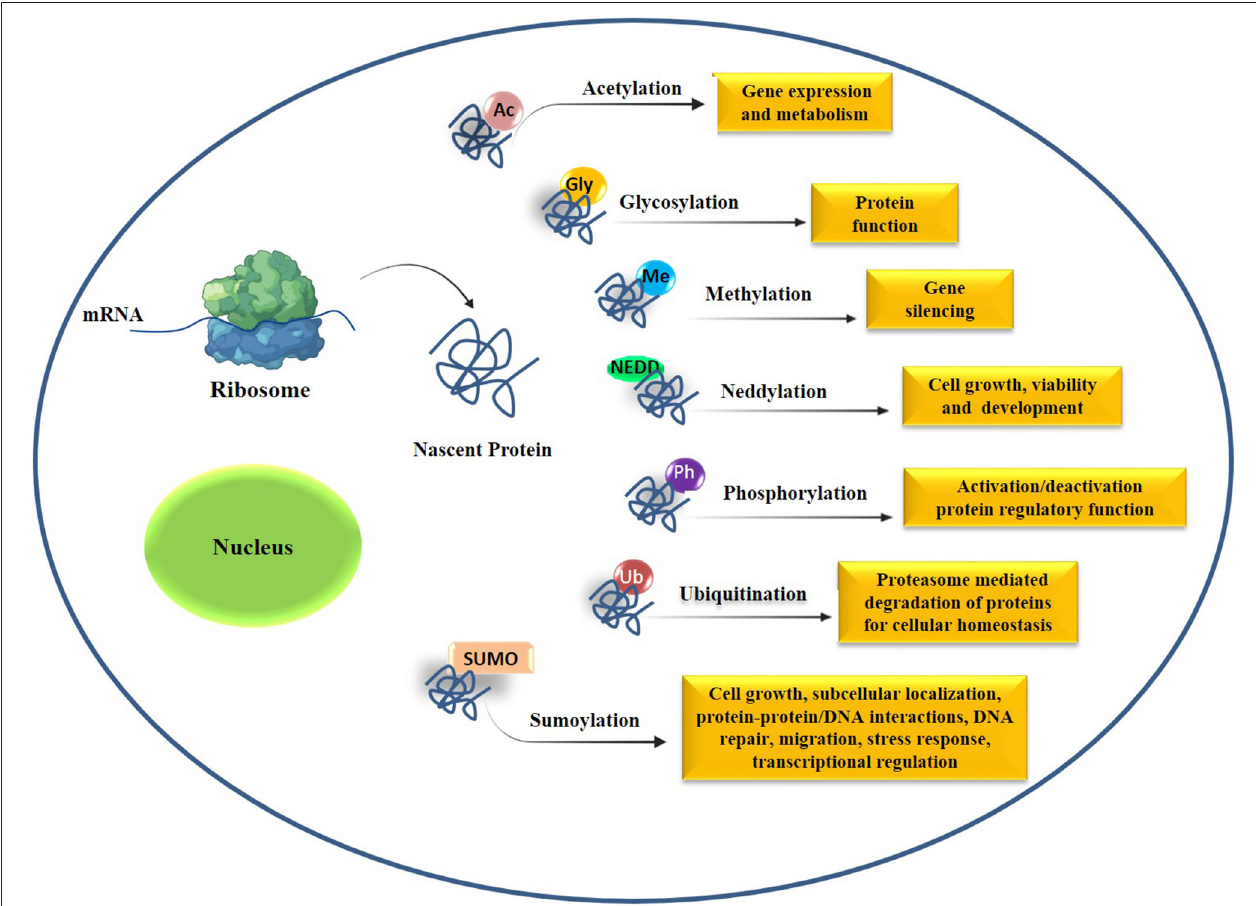
FIGURE 3 | Posttranslational modifications (PTMs) in cells and alteration in PTMs cause premature aging and aging-associated diseases. Abbreviations used in this figure: Ac, acetylation; Gly, glycosylation; Met, methylation; NEDD, neddylation; Ph, phosphorylation; SUMO, sumoylation, Ub, ubiquitination.